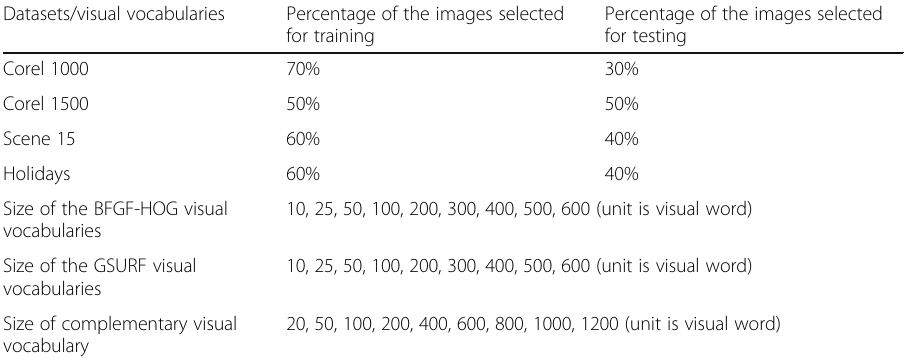
Table 2 Detail of experimental parameters of the proposed method Datasets/visual vocabularies Percentage of the images selected Percentage of the images selected for training for